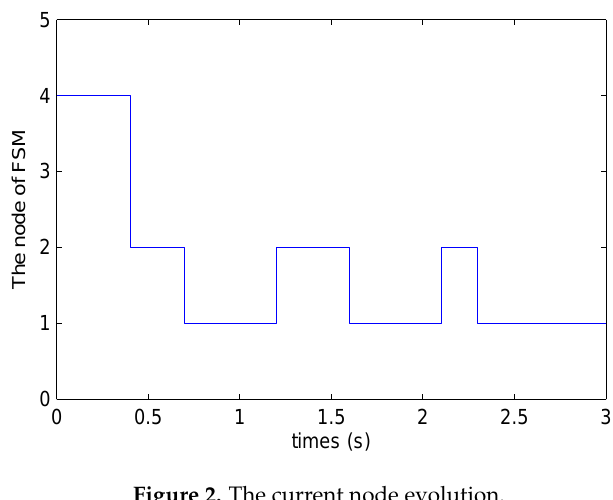
Figure 2. The current node evolution.